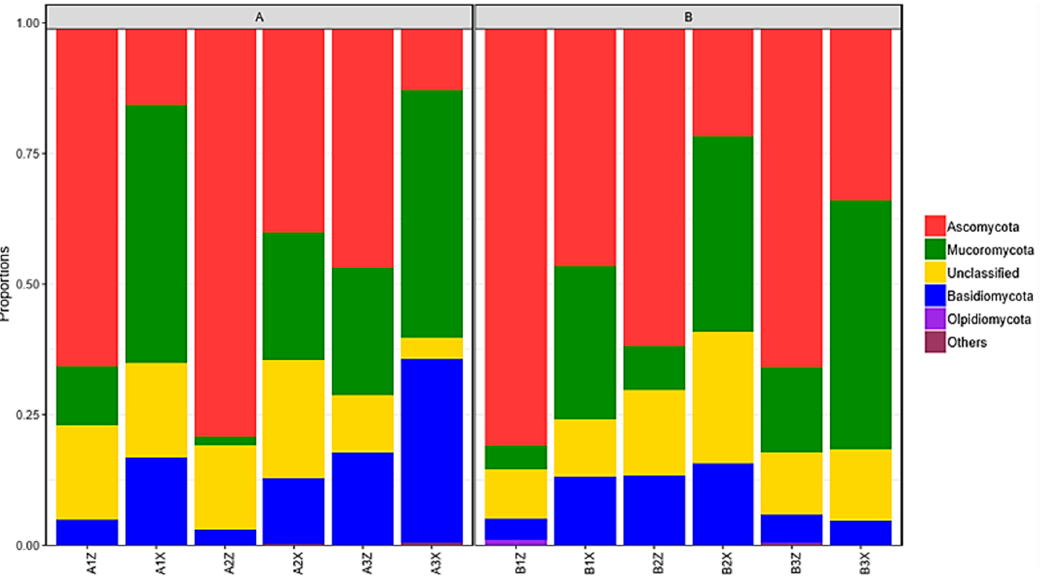
Figure 7. Differential analysis of horizontal fungus abundance in litter. Difference of fungal abundance between ( a ) litter layers of plantation forest and original Korean pine forests, ( b ) middle layer and lower litter layers in Korean pine plantation forest, and ( c ) middle and lower litter layers in original Korean pine forest. *, significant difference between the two groups of data ( n = 3, p < 0.05); **, very significant difference between the two groups of data ( n = 3, p < 0.01); ***, very significant difference between the two groups ( n = 3, p < 0.001). 3.2.4. LEfSe Analysis of Litter Fungi There were 24 biomarkers (LDA score >3) for fungal LEfSe analysis in both the original and plantation forests (Figure 8a). There were 19 taxa in the original forest. On the whole, Tetracladium contributed the most to the original forest, while there were 5 taxa in the plantation forest. Hypocreales contributed the most to the plantation forest, followed by Chloridium .